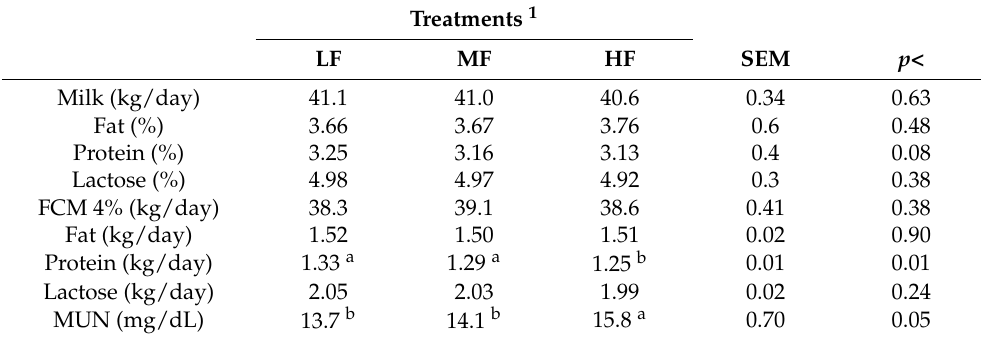
Table 2. Least squares means of milk and milk solid contents and